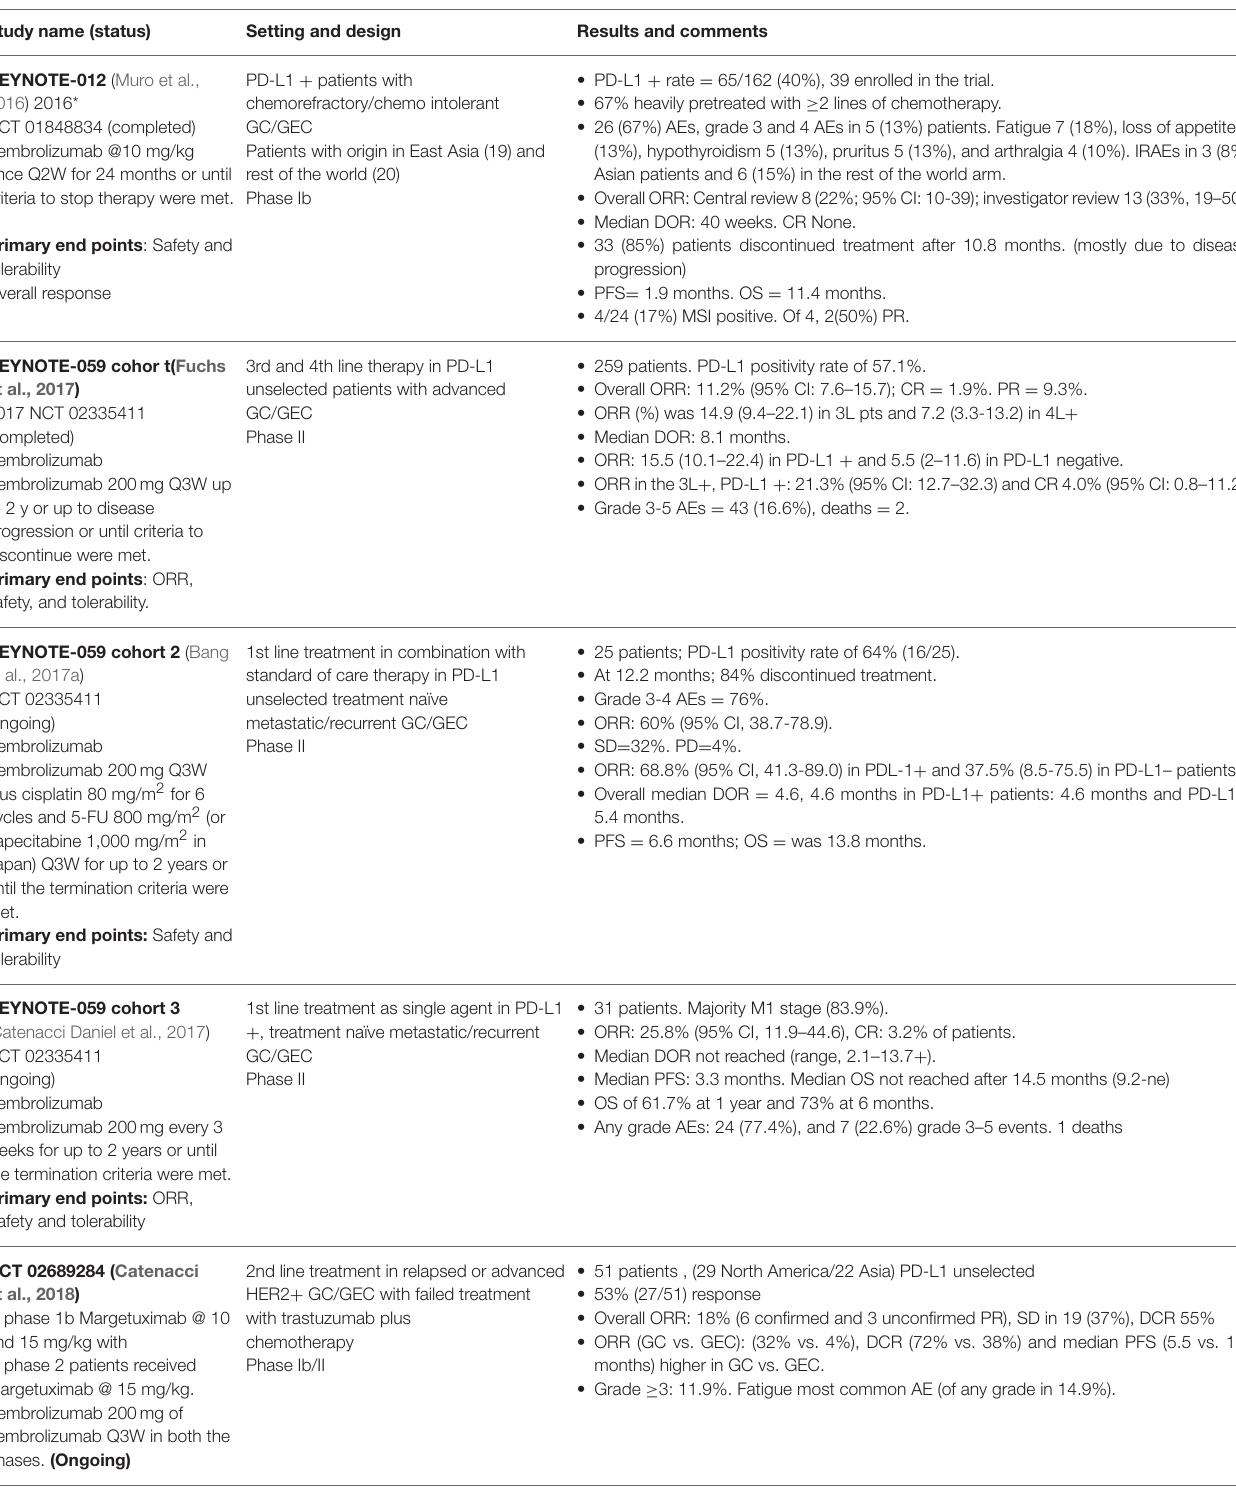
TABLE 1 | Summary of selected clinical trials on emerging therapies for the treatment of gastric